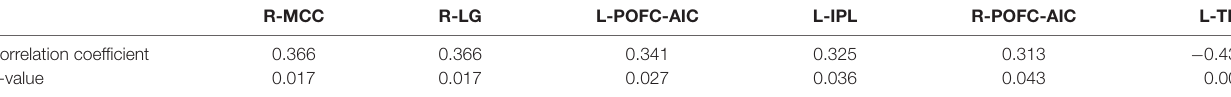
TABLE 3 | Significant correlations between the MMSE score and functional connectivity of brain